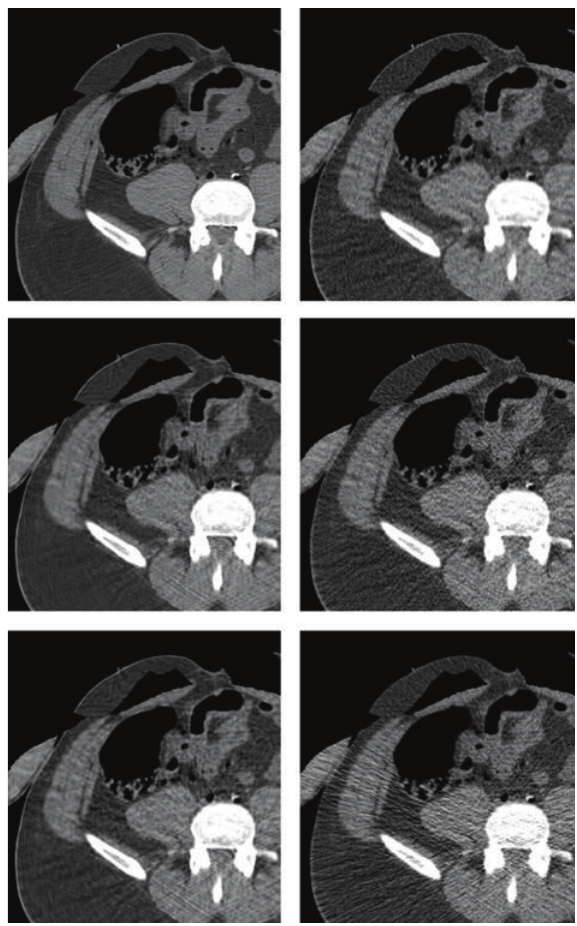
Figure 13: Abdomen reconstruction. Images are listed left to right and displayed in HU range of [−220, 350] . First row: reference image, PWLS. Second row: our method (stage II), ATM. Third row: our method (stage I), FBP.